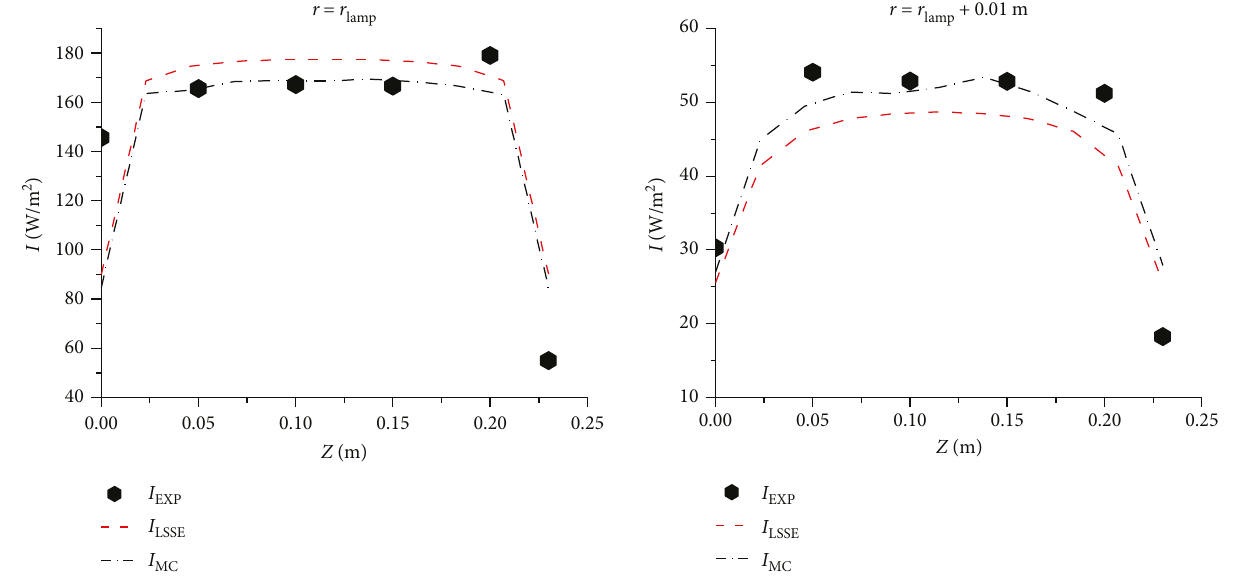
Figure 5: Emission model results. Calculated and experimental incident radiation pro fi